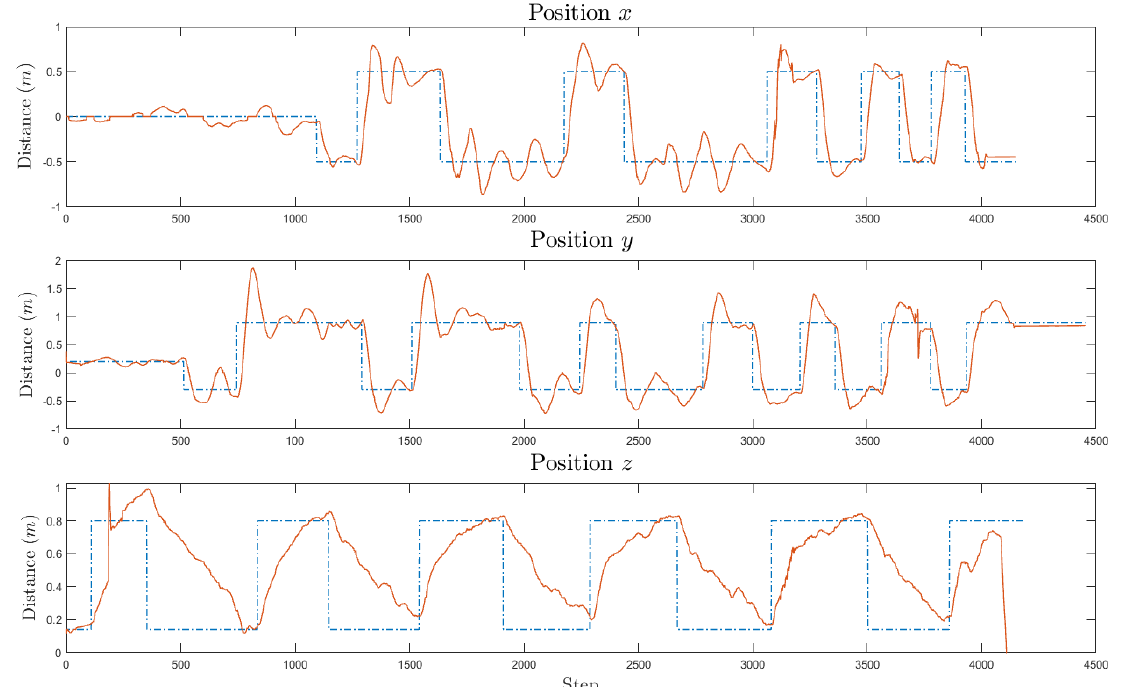
Figure 12. Experimental results for position of the UAV. One MLP module for each axis is used and they are trained online. The desired value is represented by the dashed line and the output of the system with the solid line.